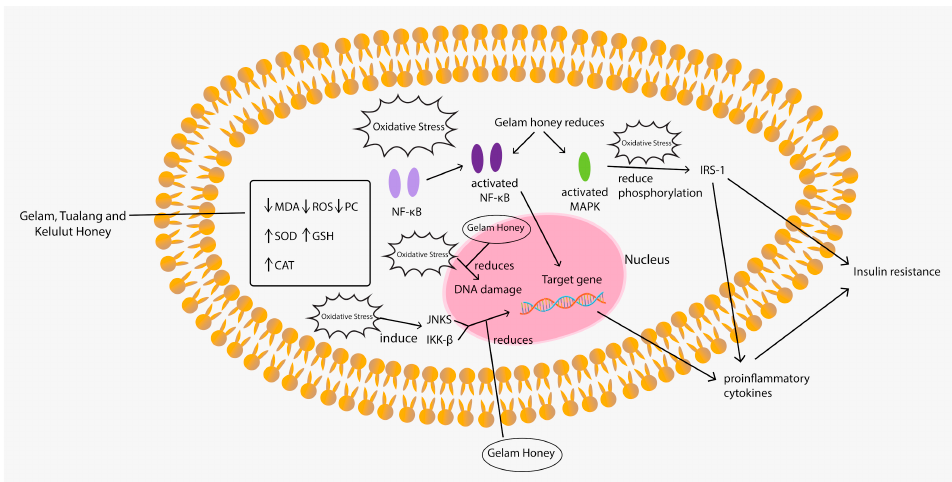
Figure 2. Anti-oxidative mechanism of Tualang, Gelam and Kelulut honeys. ROS: reactive oxygen species; MDA: malondialdehyde; SOD: superoxide dismutase; CAT: catalase; GSH: glutathione; PC: protein carbonyl; NF-kB: nuclear factor kappa B; MAPK: mitogen-activated protein kinases; JNKS: c-jun N-terminal kinases; IKK- β : I-kappa-B-kinase beta; IRS-1: insulin receptor substrate-1.